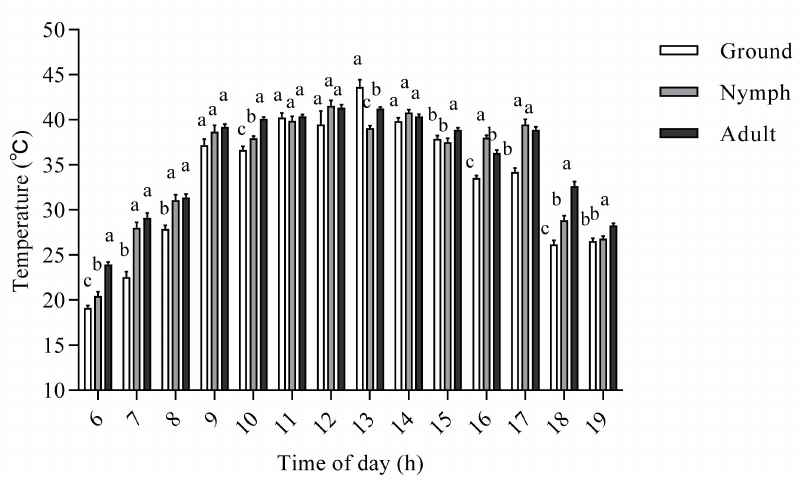
Figure 2. The average internal body temperature of Oedaleus decorus asiaticus in its natural environ- ment and the variation in ground temperature as a function of the time of day (one-way analysis of variance (ANOVA) followed by Duncan’s test, p < 0.05). Different letters indicate significant